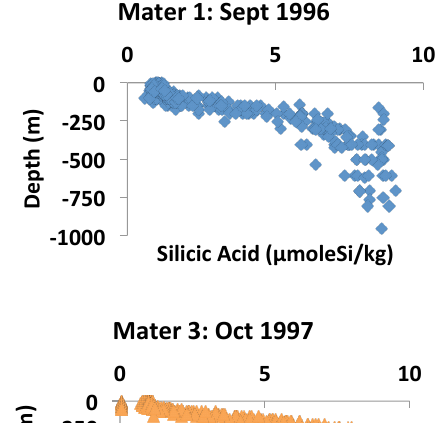
Figure 3. Porewater profiles of silicic acid with depth from a series of porewater profiles in the deep water across the eastern Mediter- Figure 3. Pore water profiles of silicic acid with depth from a series of pore water profiles in the 4 ranean Sea sampled in 1975 (Jones, 1977). deep water across the Eastern Mediterranean Sea sampled in 1975 (Jones, 1977). 5